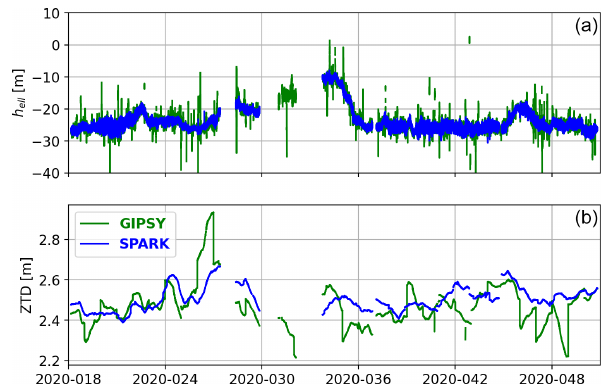
Figure 5. Comparisons of ellipsoid height (a) and ZTD (b) esti- mates for R/V Maria S. Merian using GIPSY (green) and SPARK